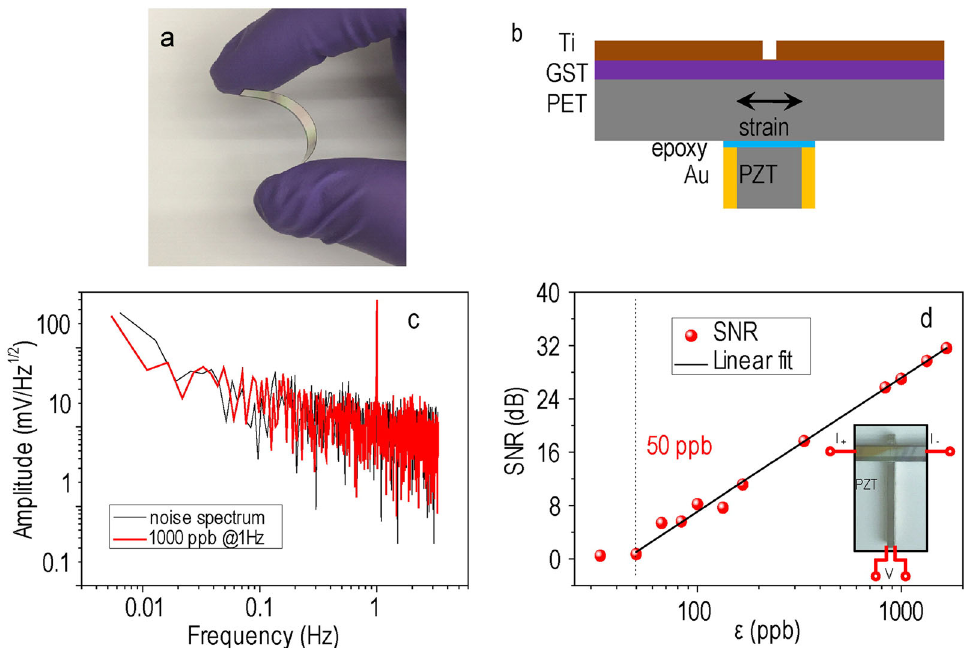
Fig. 2 a Photograph showing the fl exibility of the GST strain sensor. b Schematic illustration of the GST sensor attached to a piezoelectric PZT slab. c Spectrum analysis of the electrical response in GST strain sensor with and without strain. d SNR curve of the sensor showing a limit of detection of 50